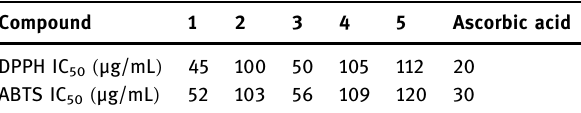
Table 2: Antioxidant activities of the synthesized